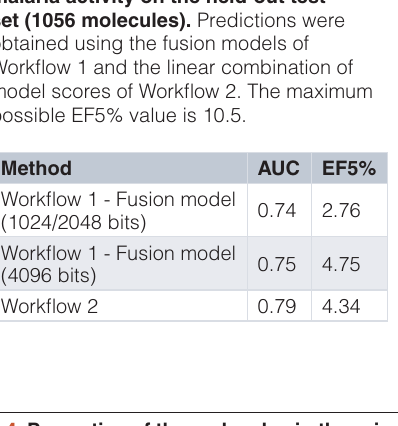
Table 4. Properties of the molecules in the primary HTS and in the held-out test set. The compounds in the primary HTS were split into 1528 actives and 293,606 inactives. The compounds in the held-out test set were split into 101 actives and 955 inactives. For the primary screen, the original classification into actives and inactives was used 23 . For the held-out test set, a cutoff of 10 μM was